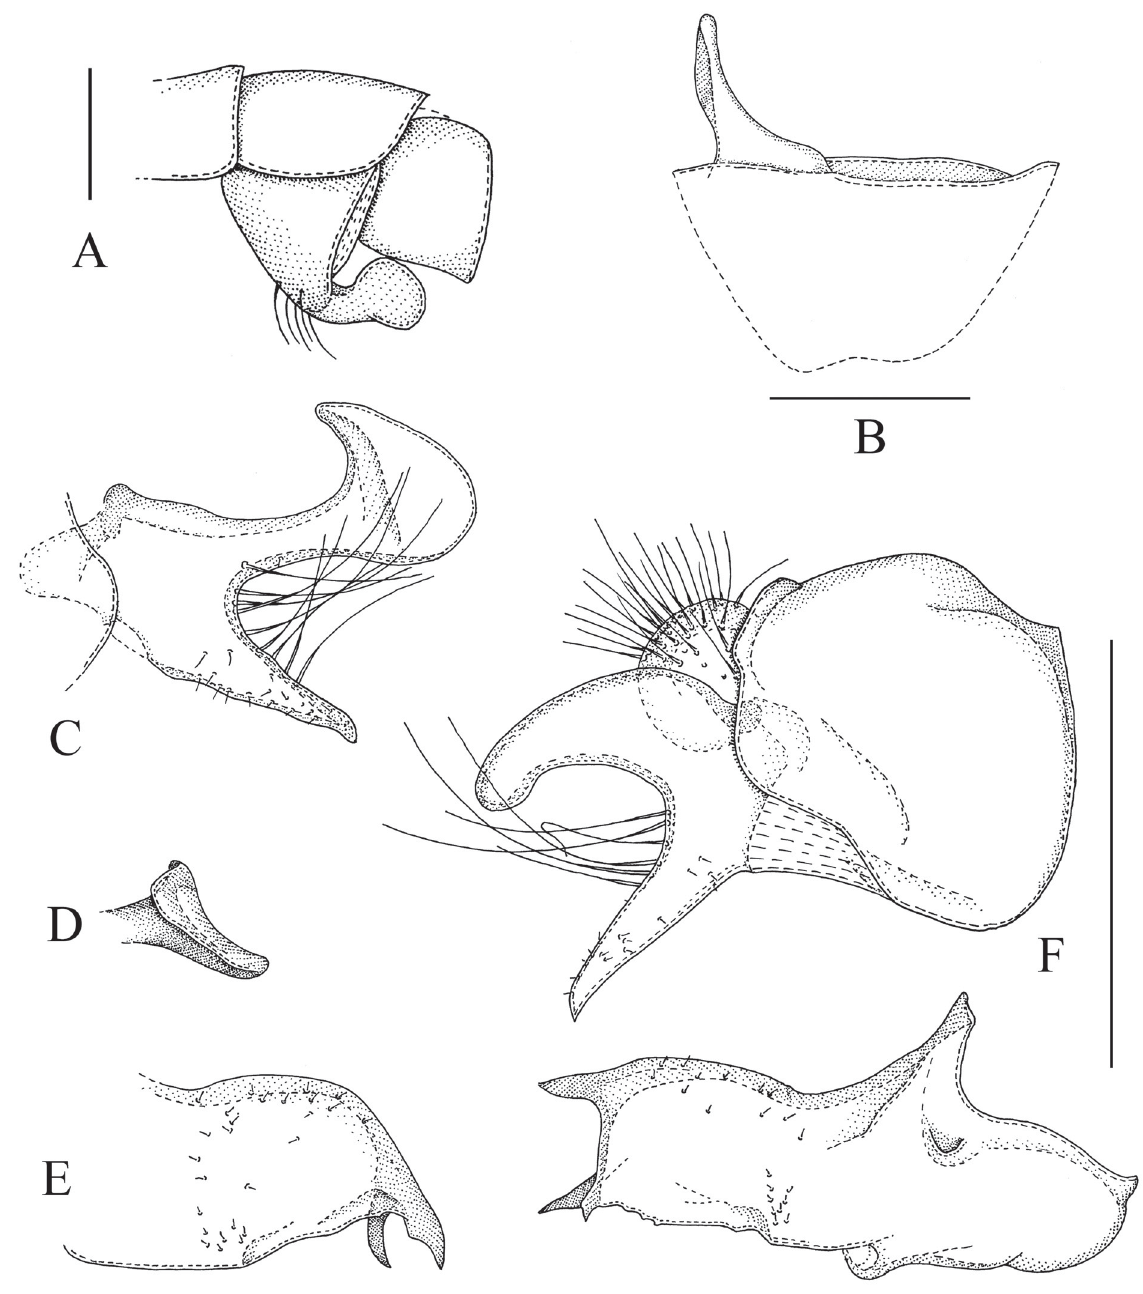
Fig. 53. Sphegina (Asiosphegina) karnataka sp. nov., holotype, ♂ . A . Posterior part of abdomen, left side lateral view. B . Sternum IV, ventral view. C . Left surstylus, lateral view. D . apex of dorsal lobe of left surstylus, dorsal view. E . Left superior lobe, lateral view. F . Genitalia, right side, lateral view. Scale bars = 0.5